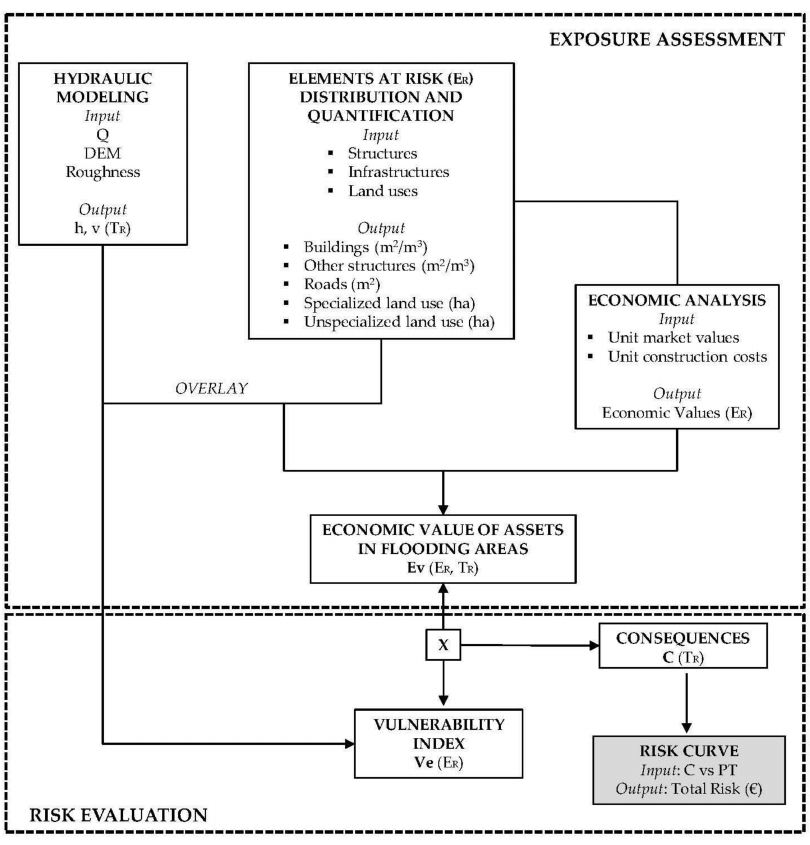
Figure 5. Proposed methodological approach for exposure and risk